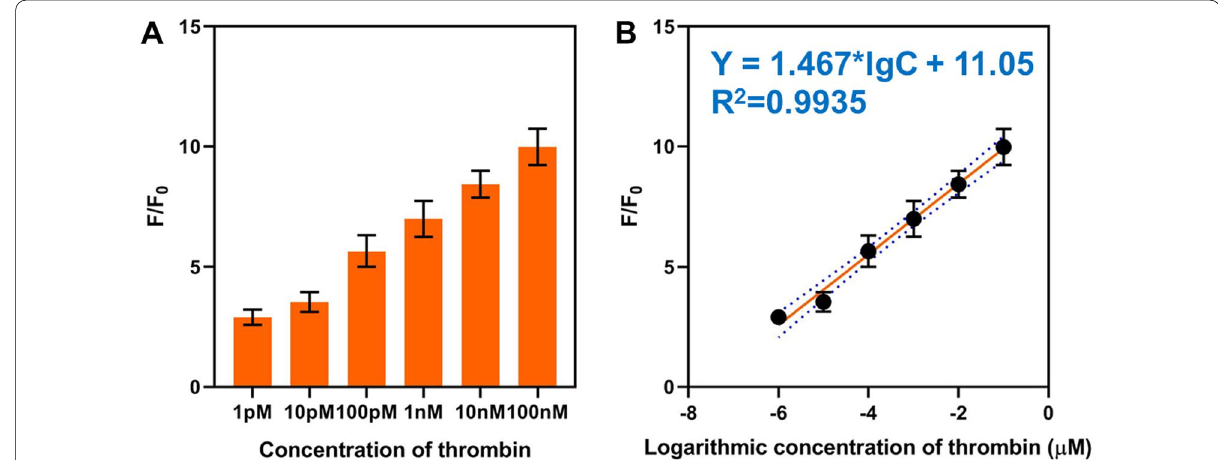
Fig. 4 Sensitivity of the established approach. a F/F0 result of the approach when detecting different concentrations of thrombin; b correlation equation between the F/F0 result and the concentration of